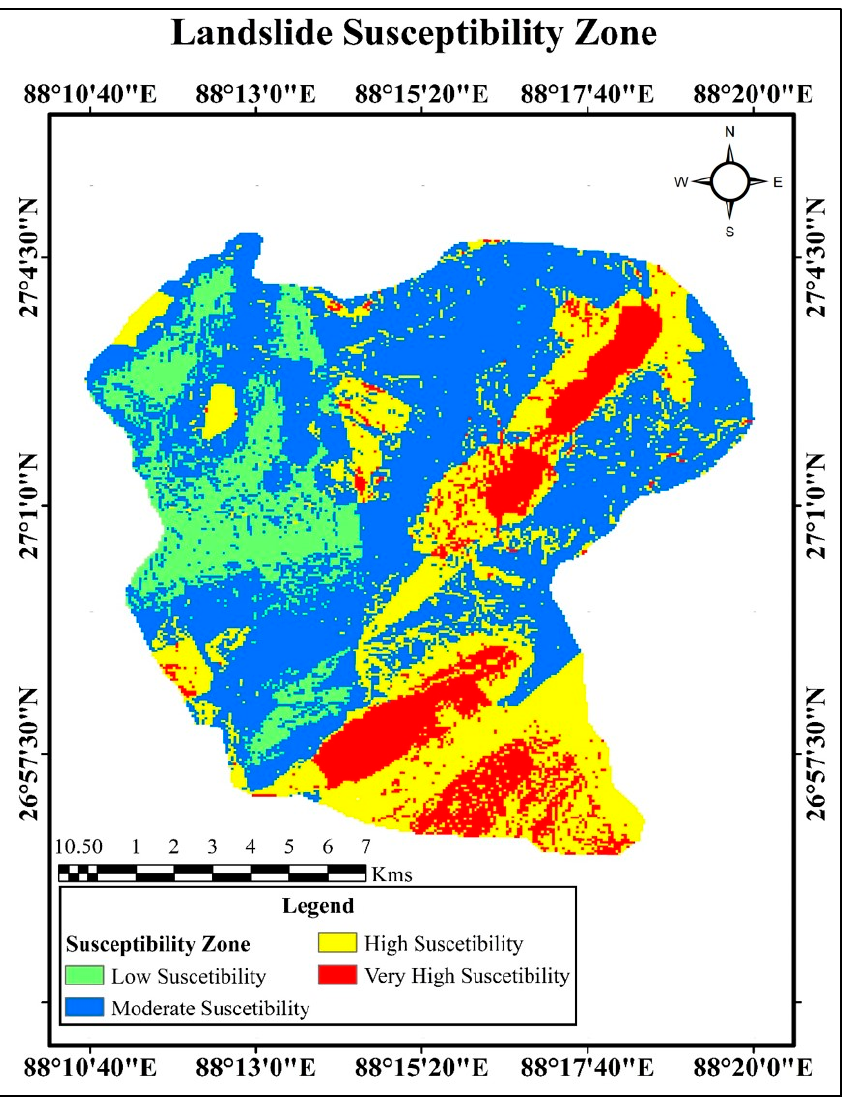
Figure 5. Final landslide susceptibility map of the part of the Darjeeling district.